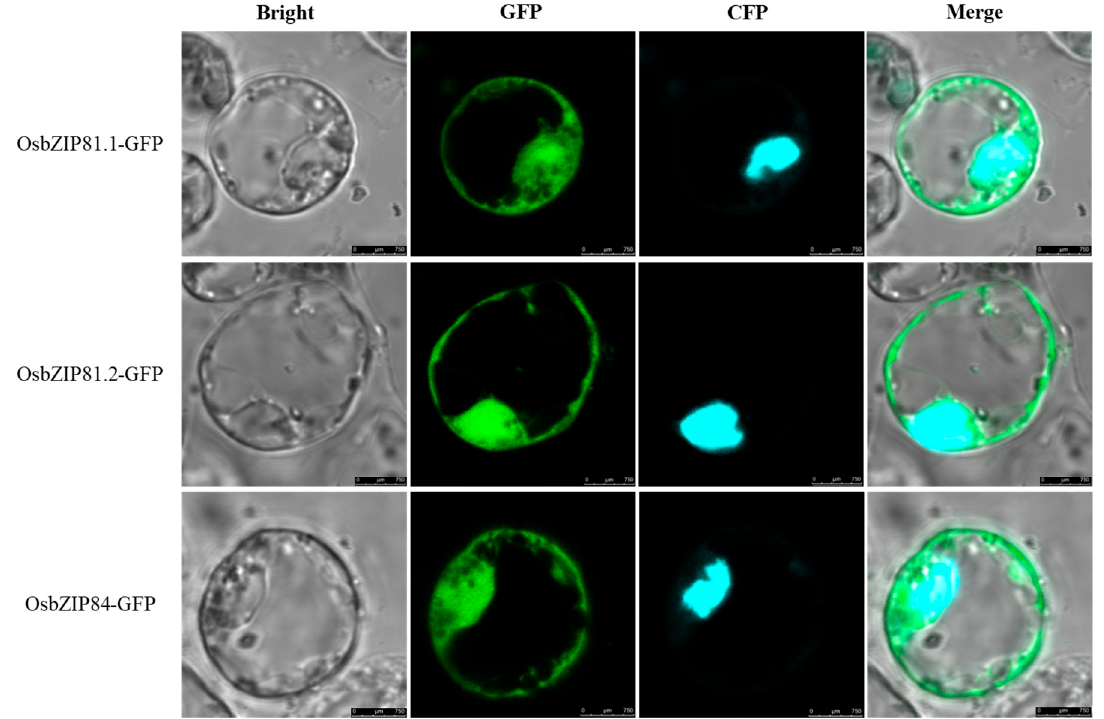
Figure 3. Subcellular localization of OsbZIP81.1, OsbZIP81.2, and OsbZIP84 proteins. Subcellular localization of OsbZIP81.1, OsbZIP81.2, and OsbZIP84 were determined in rice protoplasts. 35S::CFP-Ghd7 was used as the nucleic marker [48]. The confocal image was acquired using a confocal laser scanning microscope.